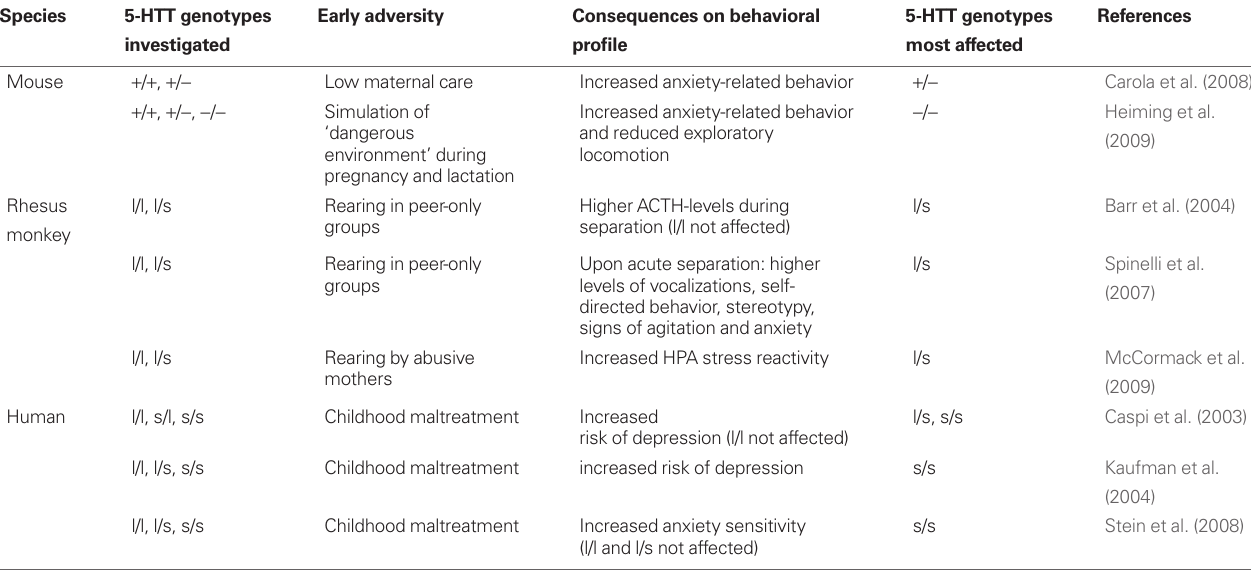
Table 1 | Selected studies focusing on the shaping of behavioral profile by early adversity and 5-HTT genotype. Species 5-HTT